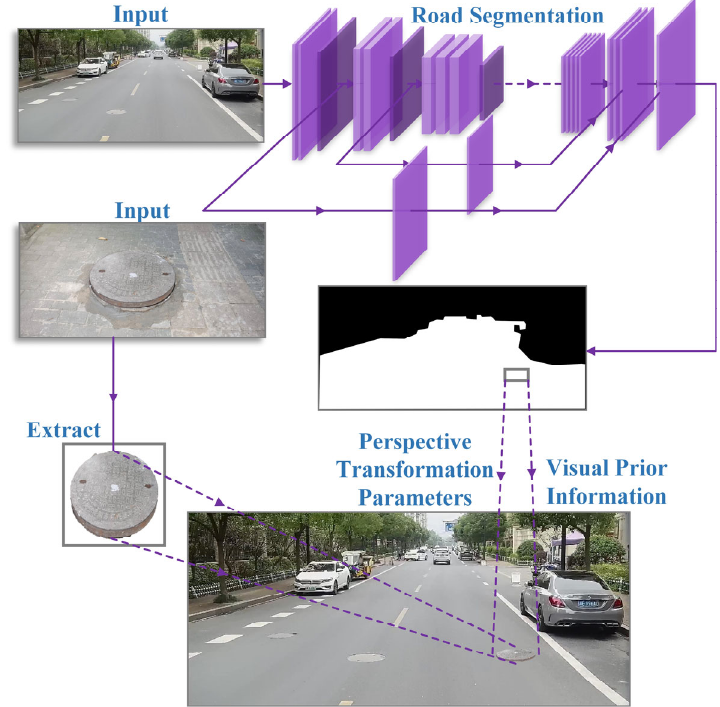
Figure 1. Overview of our proposed VGCopy-paste data augmentation for road manhole cover detection. We used the image taken by the vehicle’s camera and the abnormal manhole cover image taken by the mobile device as the input. Using the road semantic segmentation algorithm to obtain prior visual information, that is, the road segmentation map, we found the corresponding perspective transformation parameters for pasting and finally paste the extracted manhole cover samples onto the road.